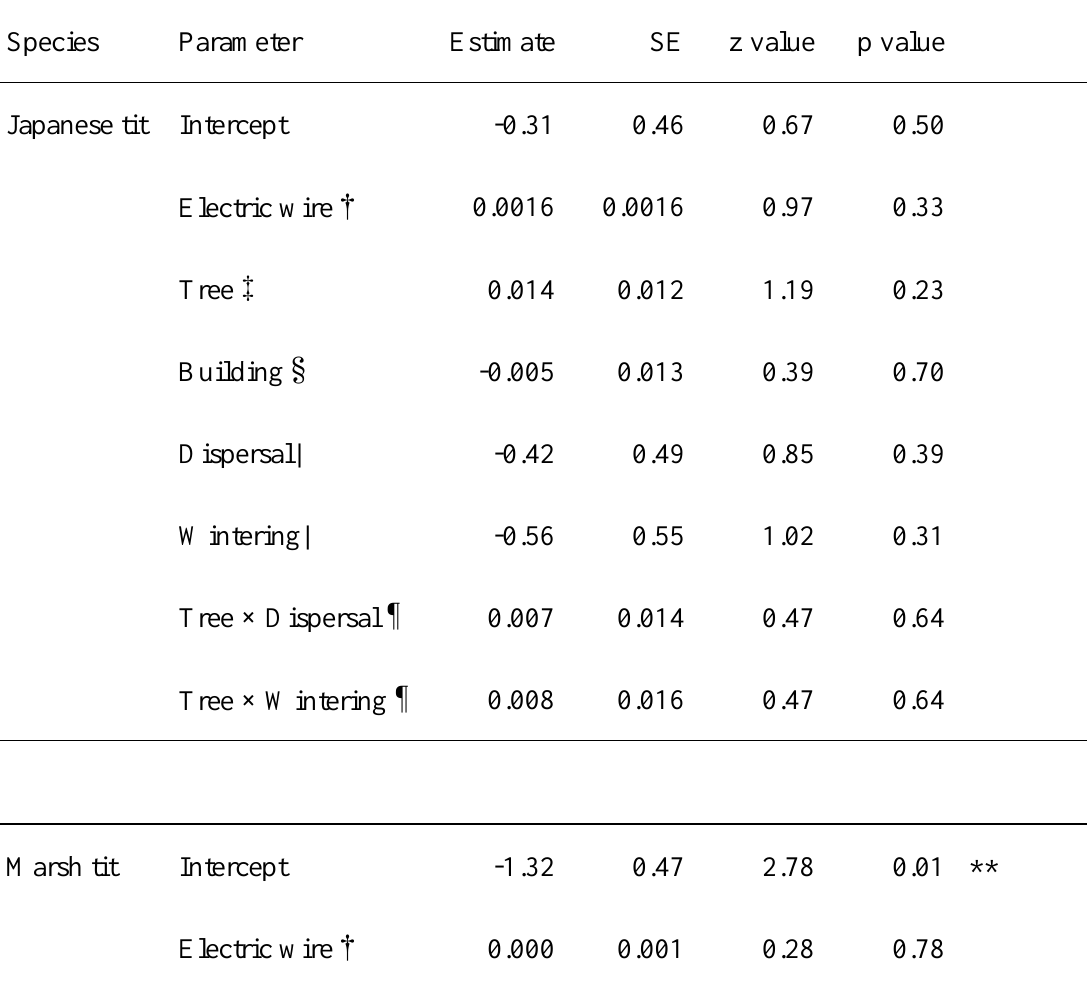
Table A3.1 . Results of model averaging with interaction between the tree cover and